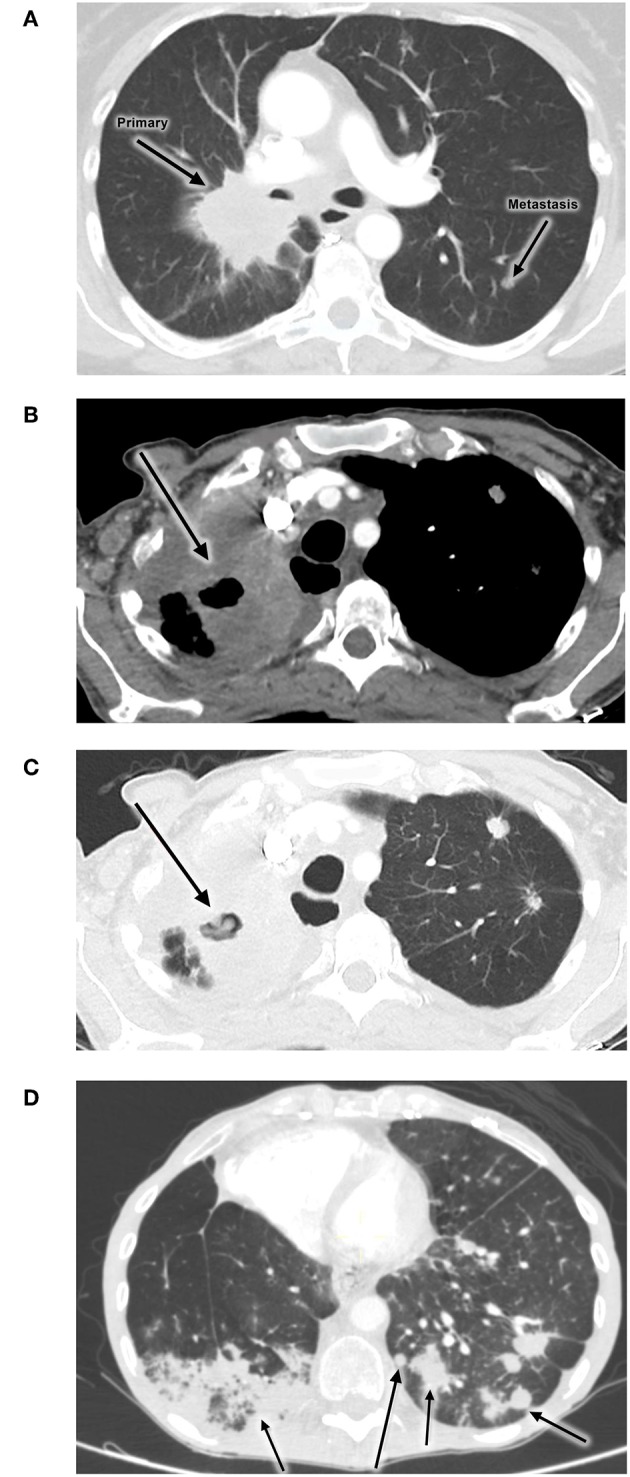
Images showing no evidence of PTB pre-treatment (A), while (B,C) show development of PTB during administration of nivolumab. (D) shows a follow-up radiological investigation demonstrating cancer progression. (A) Initial disease progression (2 Apr 2014). (B,C) PTB infection during nivolumab treatment (22 Apr 2016). (D) Progression of disease (9 May 2016).